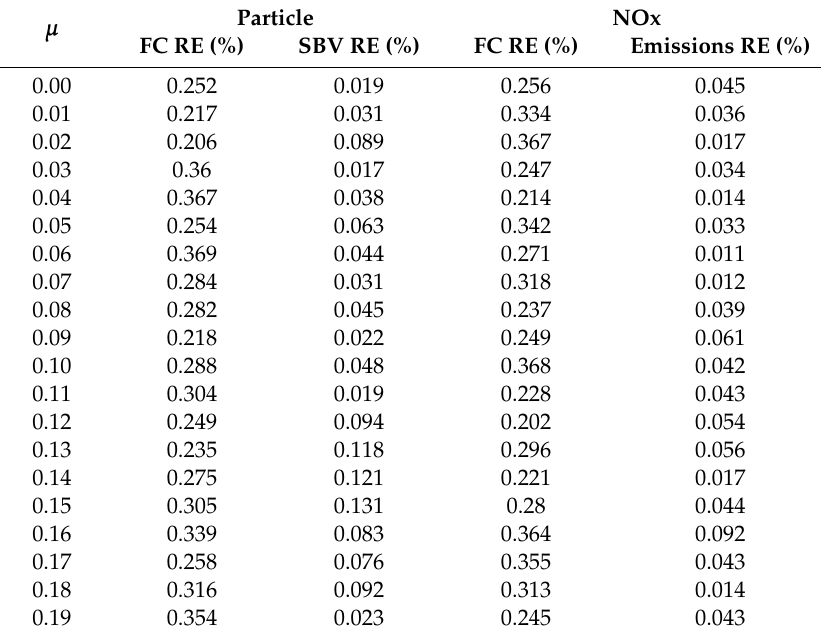
Table A2. The relative error between simulation results of DP and